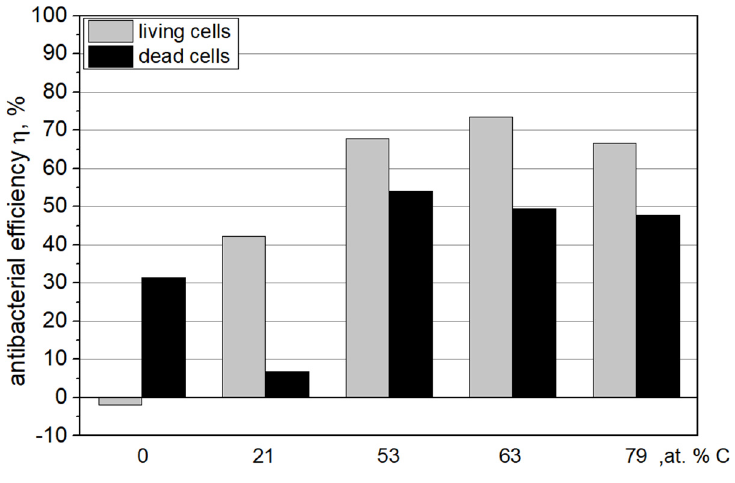
Figure 12. The relative average number (cfu/cm 2 ) of living and dead bacterial cells for all bacterial strains on the Zr–C coated samples relative to the number of bacterial cells on control sample.